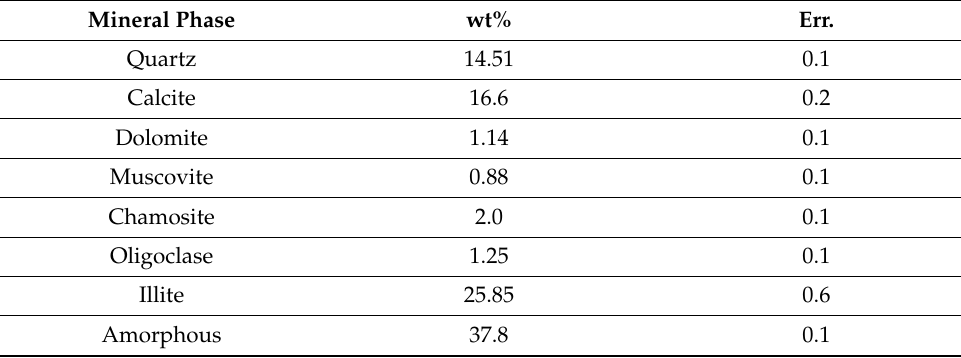
Table 5. Semi-quantitative chemical analyses performed on PR soil. Oxides wt% Na 2 O 1.49